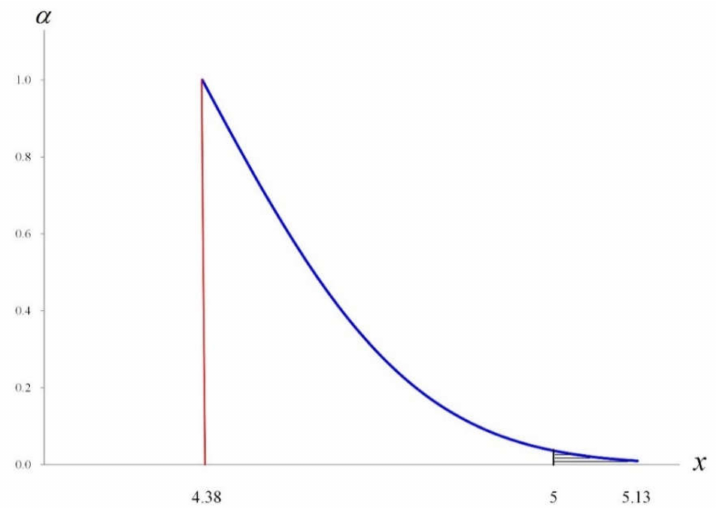
Figure 2. Membership function η ( x ) with vertical line x =